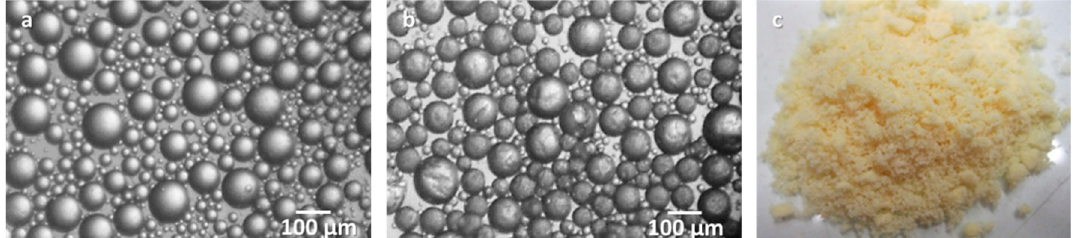
Figure 3. MCs morphology evolution during synthesis: ( a ) microemulsion before addition of the active H source, ( b ) shell formation after addition of the active H source, ( c ) free flowing powder consisting of the MCs after synthesis (scale 1:1). [107] Reprinted by permission from Springer Nature Customer Service Centre GmbH: Springer, Journal of Materials Science, “The role played by different active hydrogen sources in the microencapsulation of a commercial oligomeric diisocyanate”, by Loureiro, et al. (2020).